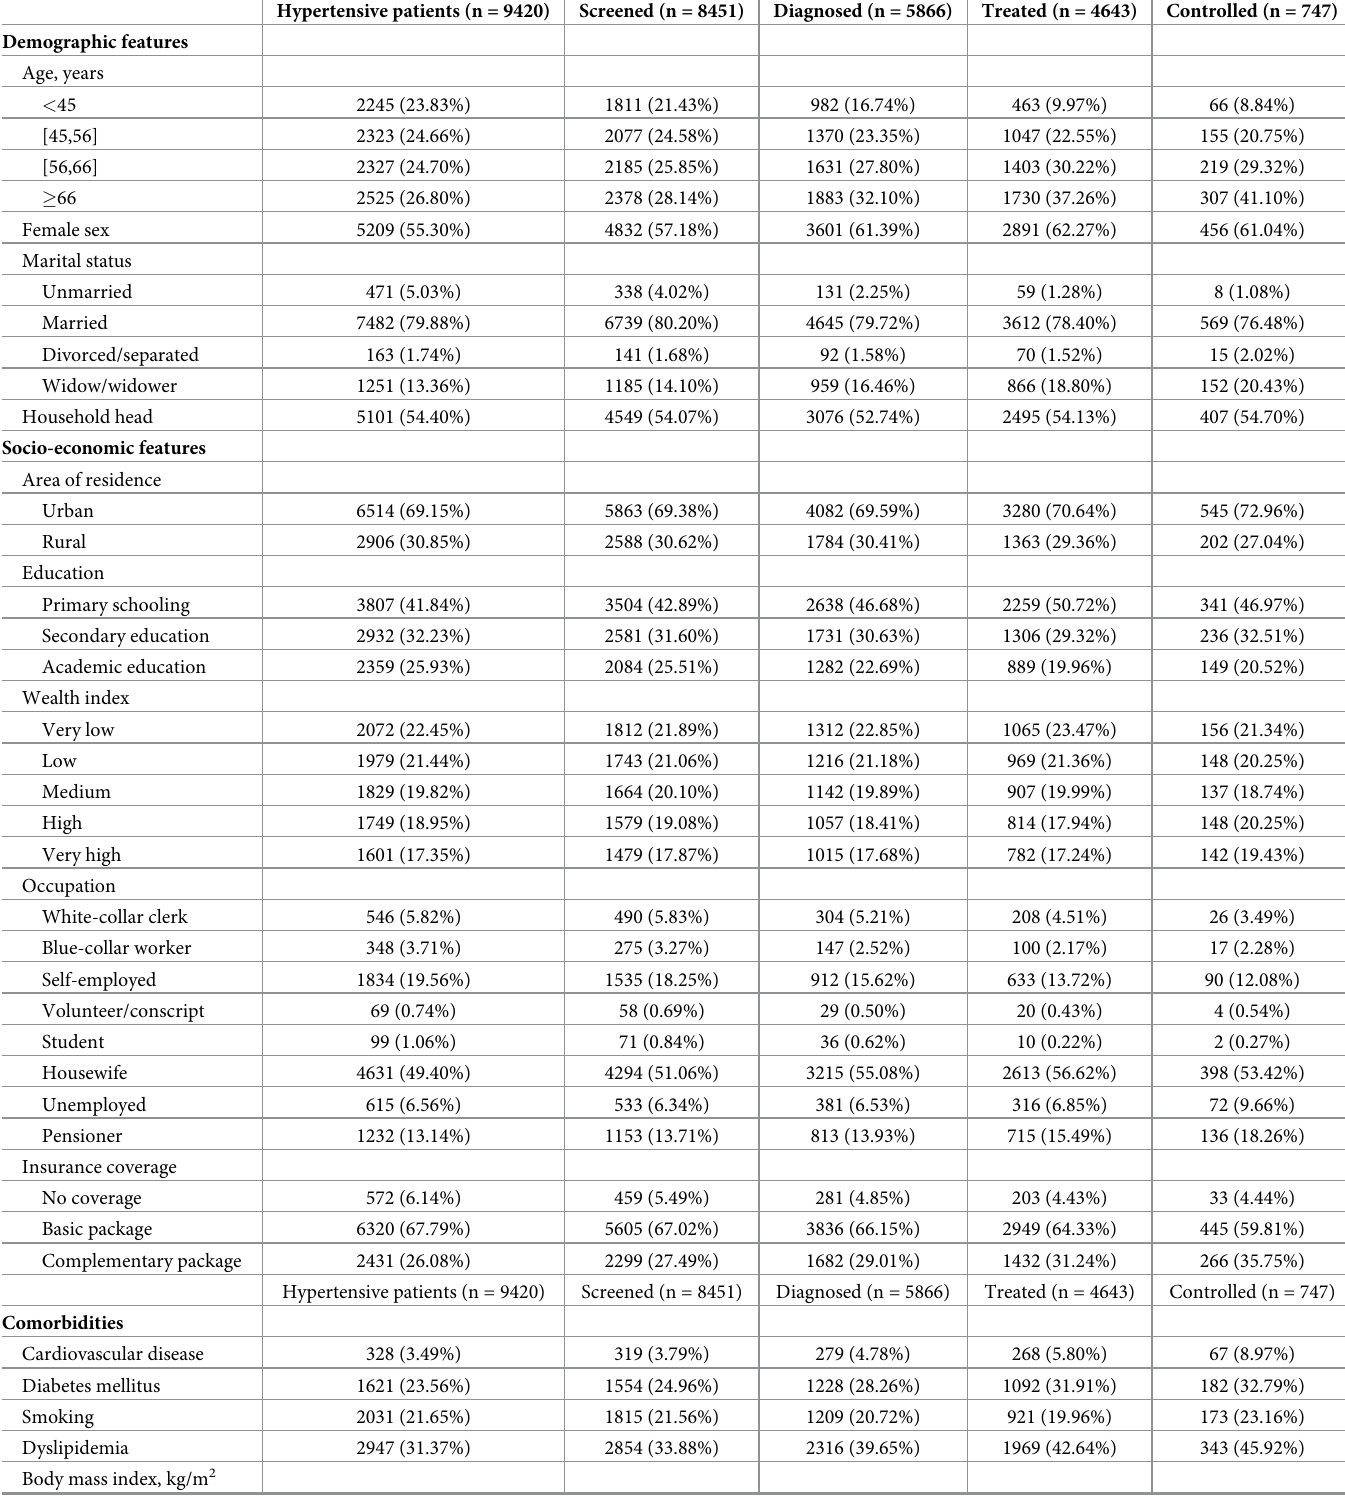
Table 1. Population characteristics in each step of the care